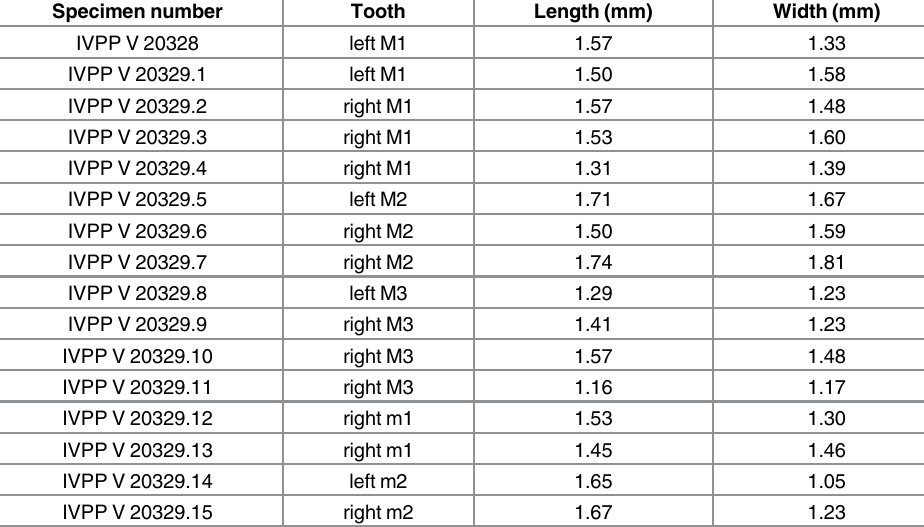
Table 1. Measurements for Irtyshogaulus minor gen. et sp.